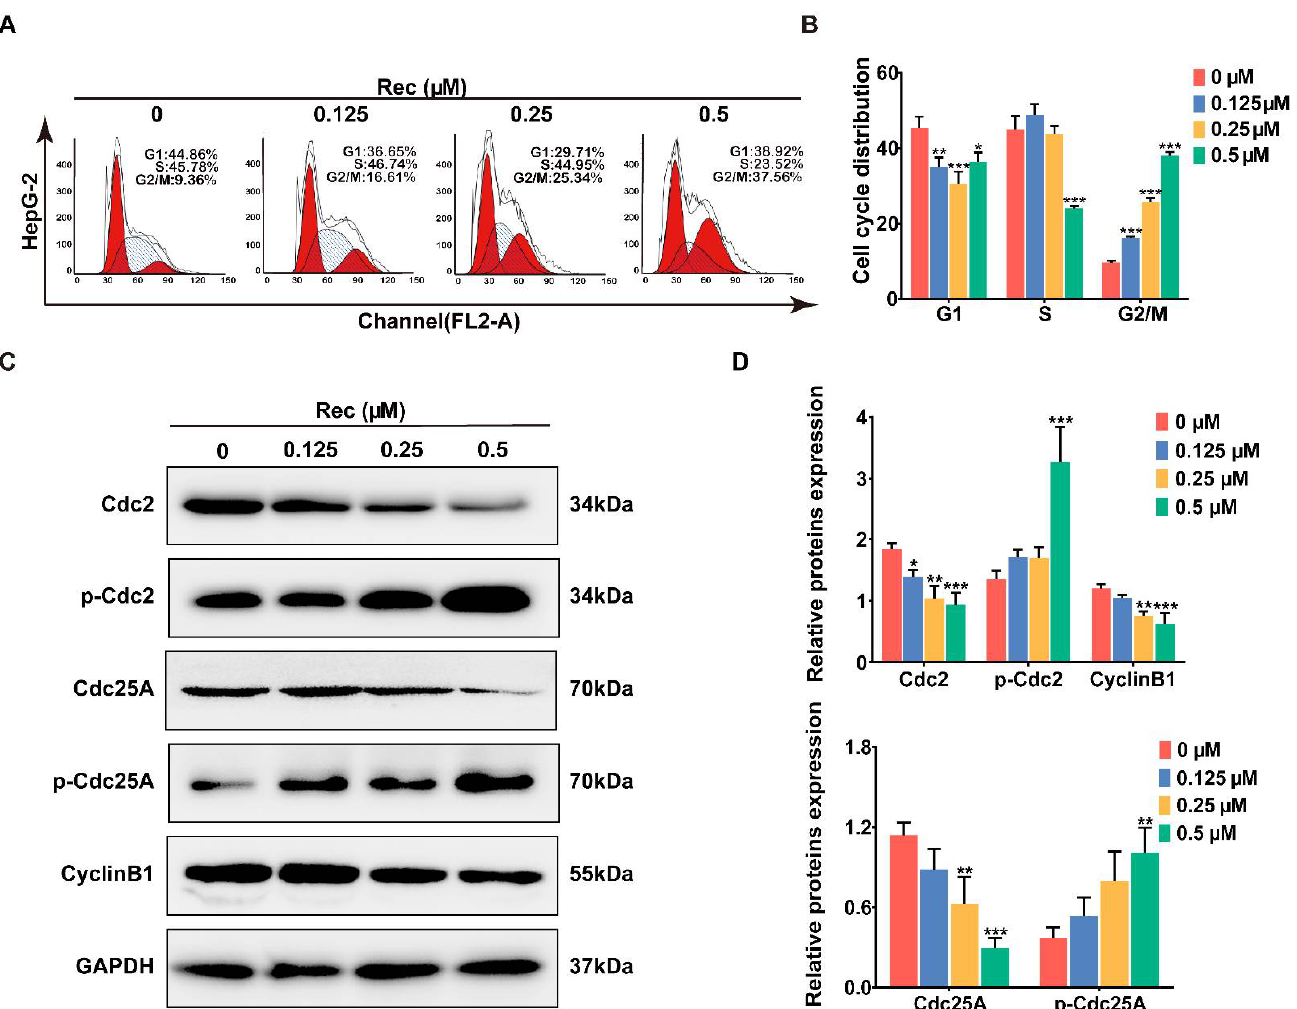
Figure 3. Resistomycin caused G2/M phase arrest in HepG2 cells. ( A , B ) Flow cytometry analysis of the distribution of HepG2 cells in the G1, S and G2 phases after treatment with 0, 0.125, 0.25 and 0.5 μM resistomycin for 24 h (each phase presented as G1-S-G2/M: red-stripes-red). ( C , D ) Western blot analysis showing that resistomycin downregulated the expression of Cdc25A, Cdc2 and Cyclin B1 and upregulated the expression of p-Cdc2 and p-Cdc25A after treatment with 0, 0.125, 0.25 and 0.5 μM resistomycin for 24 h. * p < 0.05, ** p < 0.01 and *** p < 0.001 versus 0 μM resistomycin.